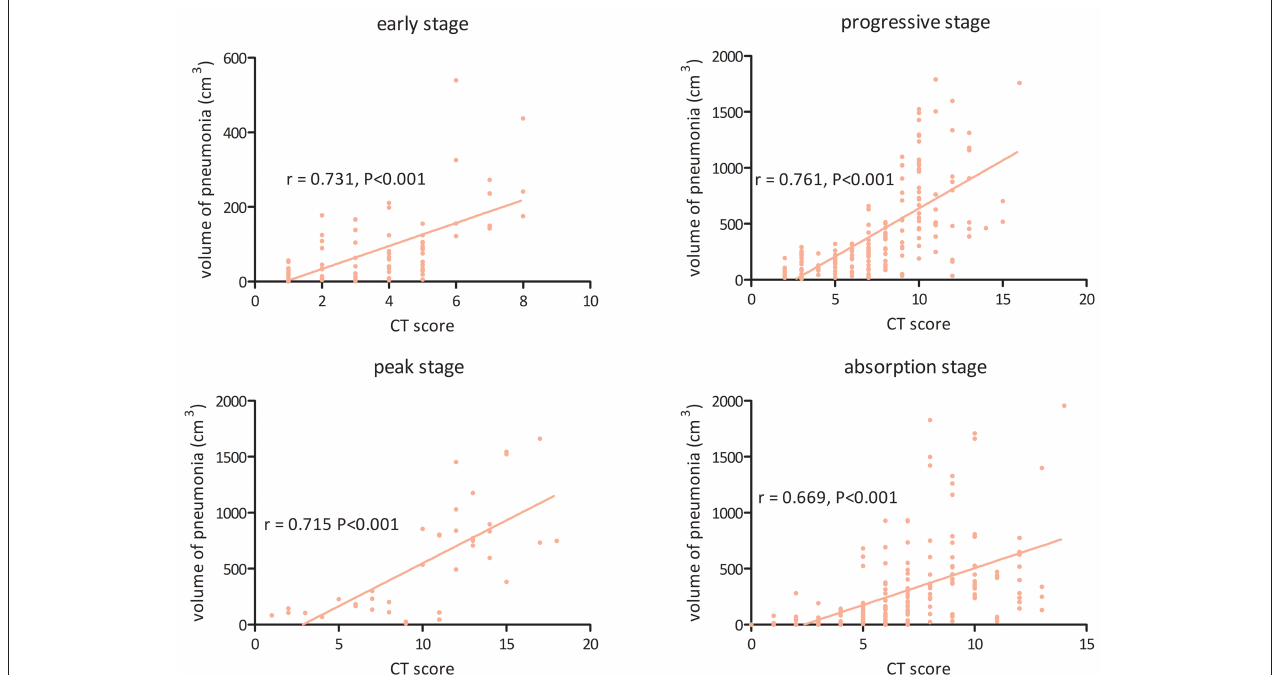
FIGURE 5 | The association between visual CT score and volume of pneumonia measured by the computer-aided diagnosis system in the four stages of COVID-19 pneumonia.